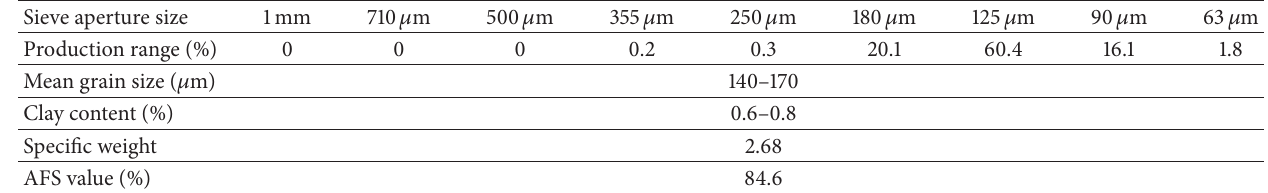
Table 2: Physical properties of the aggregate used in the mixtures.